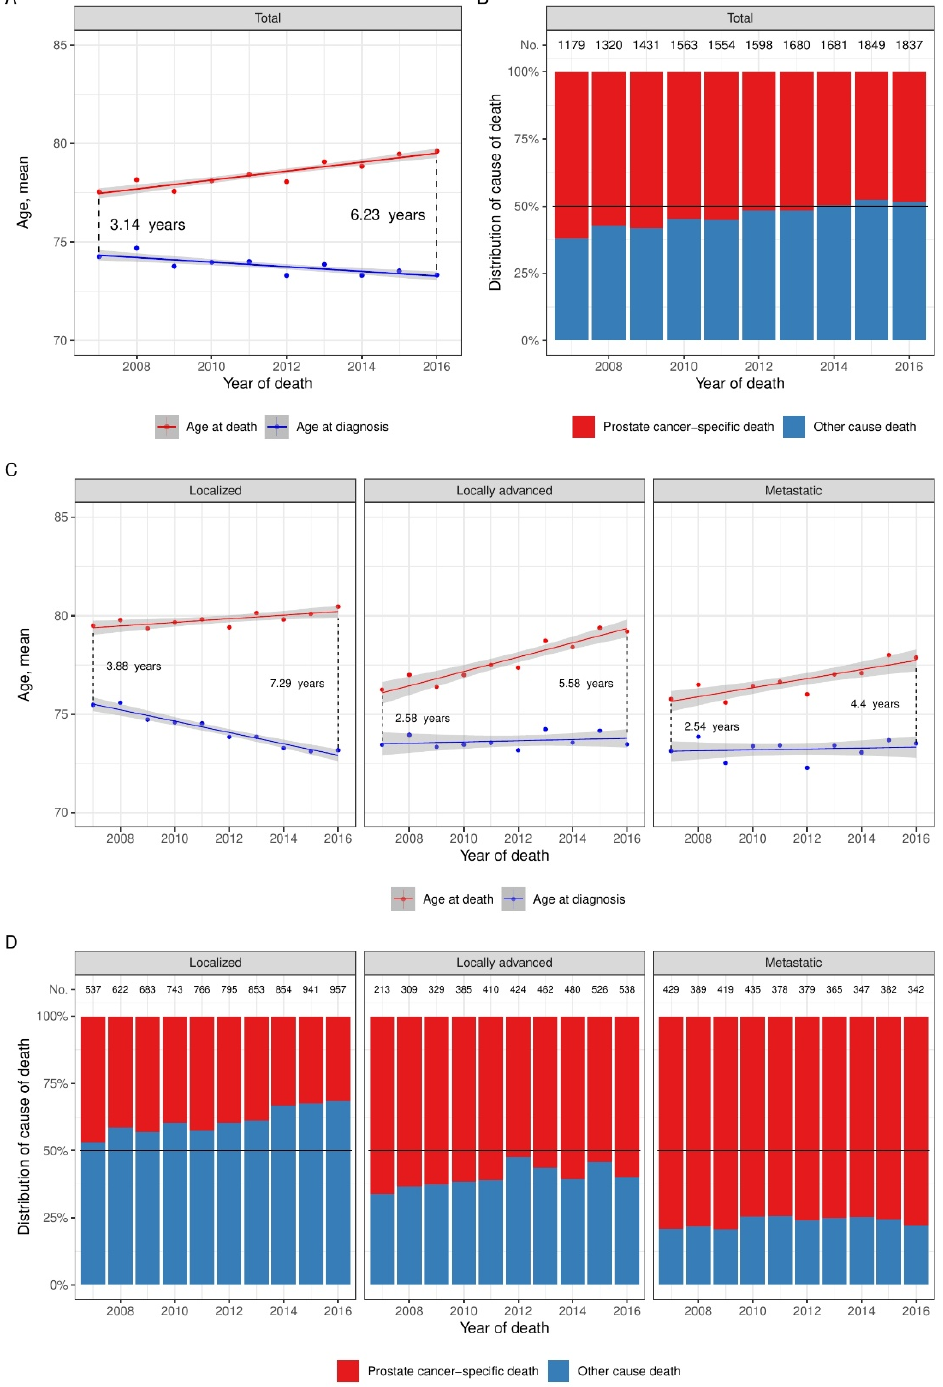
Figure 3. Temporal trends in age at diagnosis, age at death and distribution of cause of death among dead men with prostate cancer, total cohort ( n = 15,692). ( A ) Linear regression of observed age at death and diagnosis with in grey the 95% confidence interval (95CI) of the regression, and the mean age at diagnosis and mean age at death per year of death in the total cohort. Differences in time from diagnosis to death are calculated as the difference in the predicted age from the linear regression models, respectively; ( B ) Overall distribution of cause of death per year of death. The total number of patients in corresponding year is depicted above each bar; ( C ) Linear regression of observed age at death and diagnosis with the 95CI of the regression in grey, and the mean age at diagnosis and mean age at death per year of death stratified by stage at diagnosis. Differences in time from diag- nosis to death are calculated as the difference in the predicted age from the linear regression models, respectively; ( D ) Overall distribution of cause of death per year of death. The total number of pa- tients in the corresponding year is depicted above each bar, abbreviated by “No”.